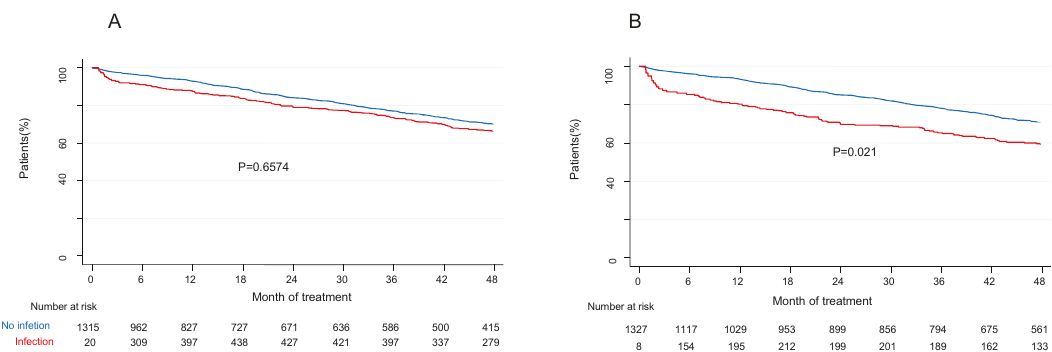
Fig. 4 Impact on overall survival of infection. A Impact on overall survival of any-grade infection and B severe infection.